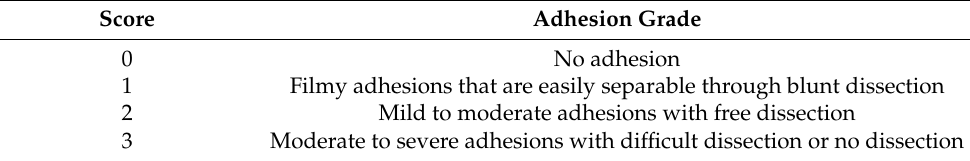
Table 1. Adhesion scoring system.